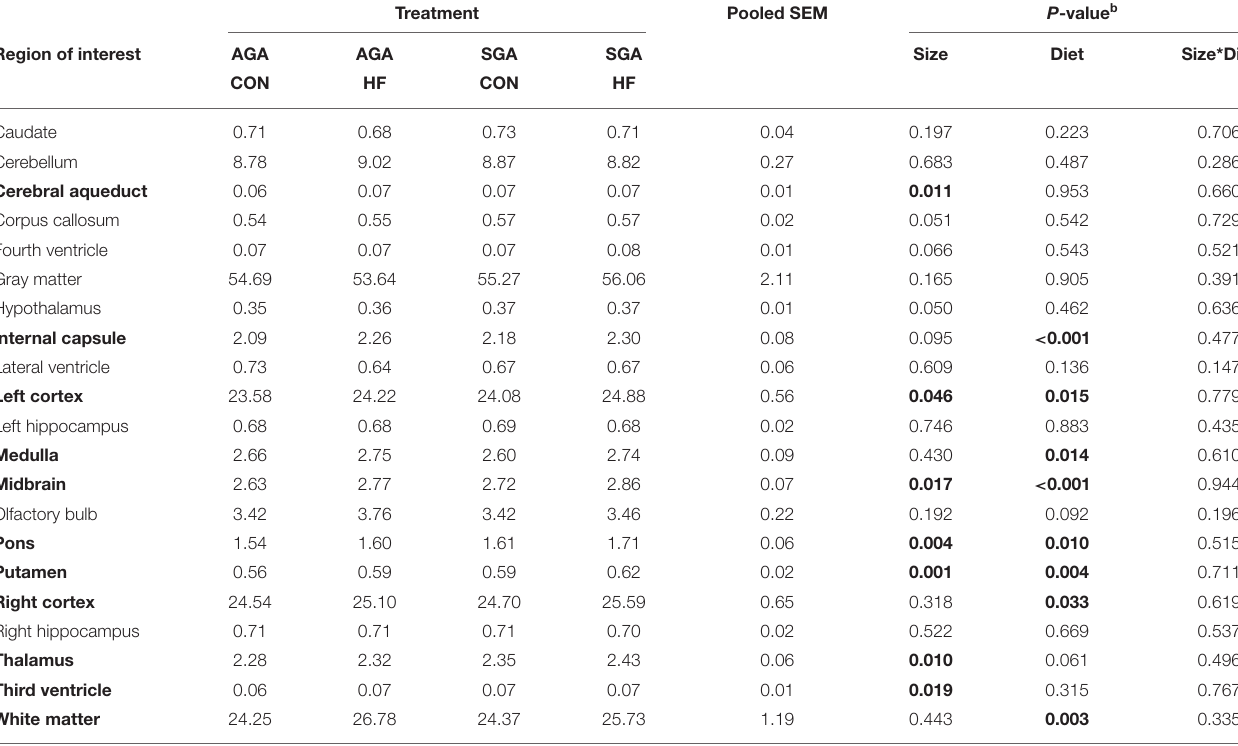
TABLE 2 | Effects of birth weight and HF on relative brain region volumes (% of whole brain) of 4 week-old piglets a . Treatment Pooled SEM P -value b